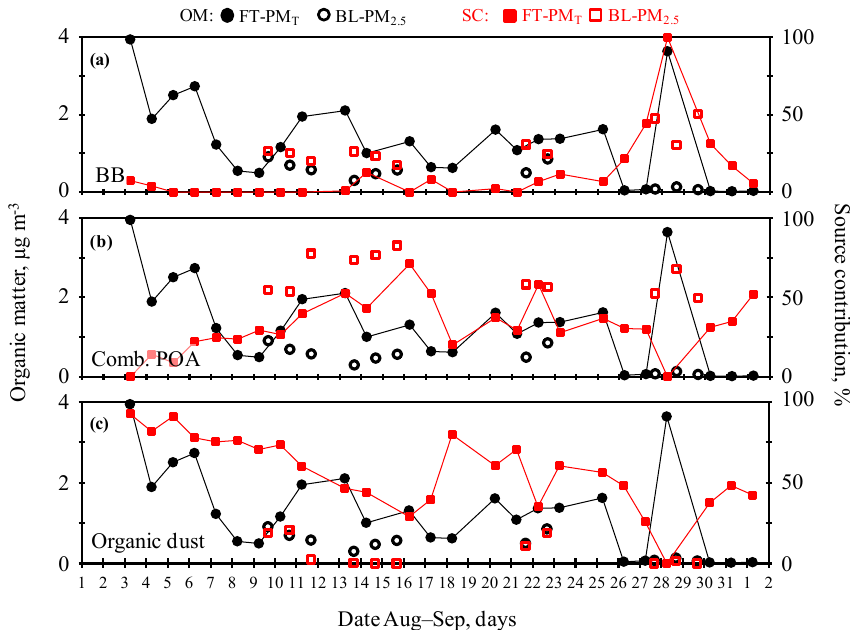
Figure 6. Time series of the total organic matter (OM; circle markers) and the source contribution (SC; square markers) to the organic matter determined for the FT-PM T (filled markets) and the BL-PM 2 . 5 samples (open markers). Sources: (a) biomass burning (BB), (b) combustion (comb.) POA and (c) organic